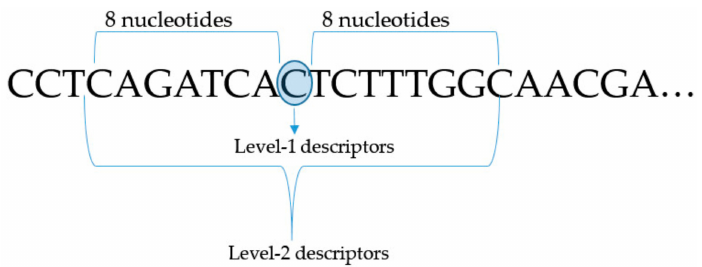
Figure 4. Principle of data processing to compile study datasets. The center position for creating MNA descriptors for a given example is represented in a blue